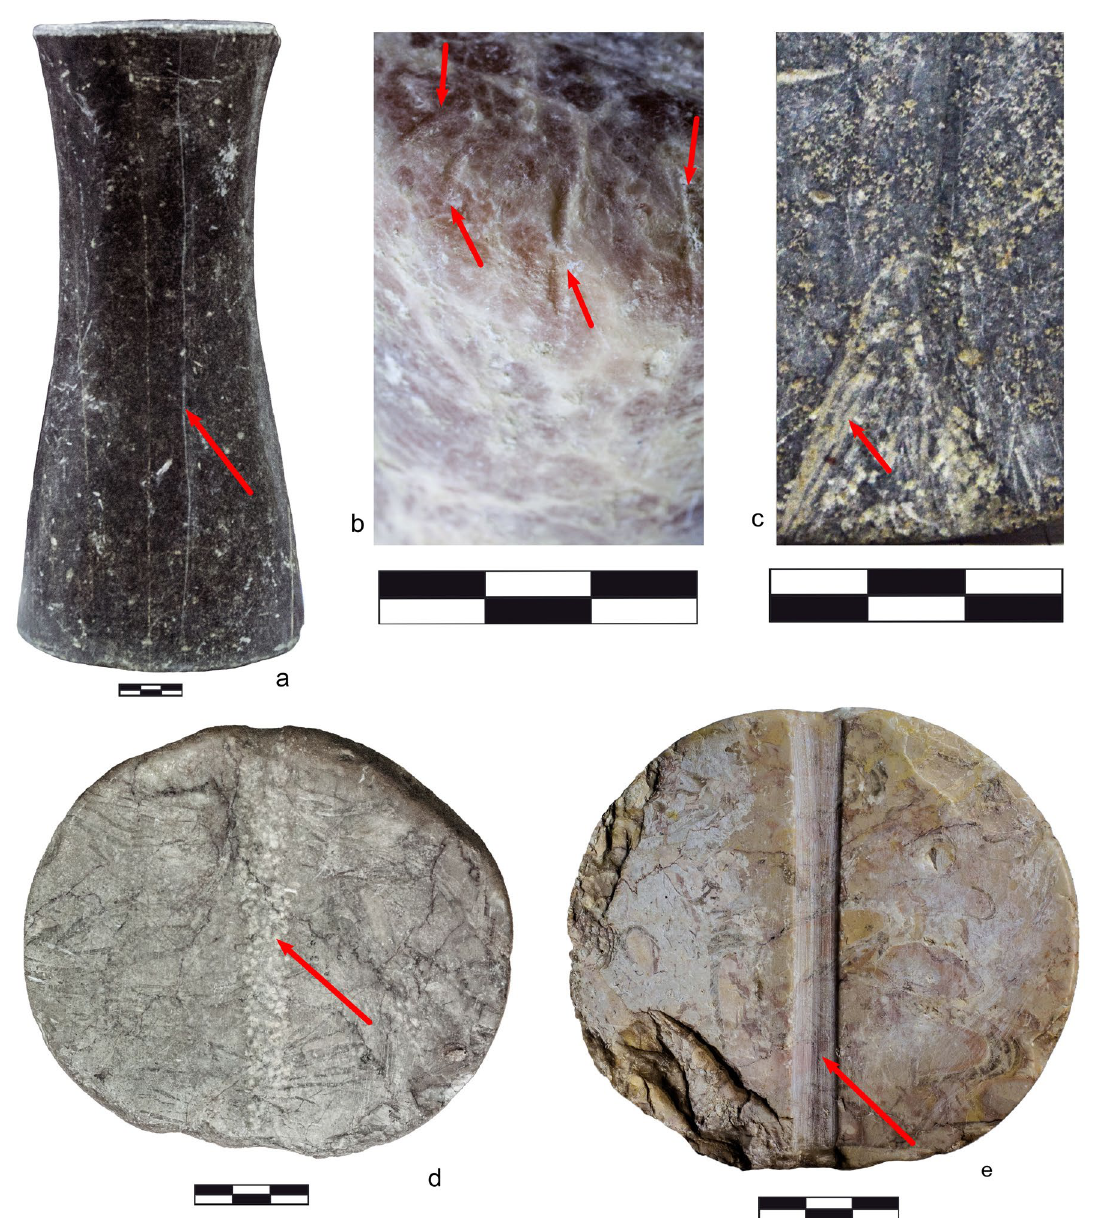
Figure 20. The main technological methods of manufacturing grooves on miniature columns: a. marking the groove by scratching; b. marking the groove by cutting; c. marking the groove by sawing; d. traces of pecking; e. sawing marks. Scale bar is 3 cm long, separated into three 1 cm